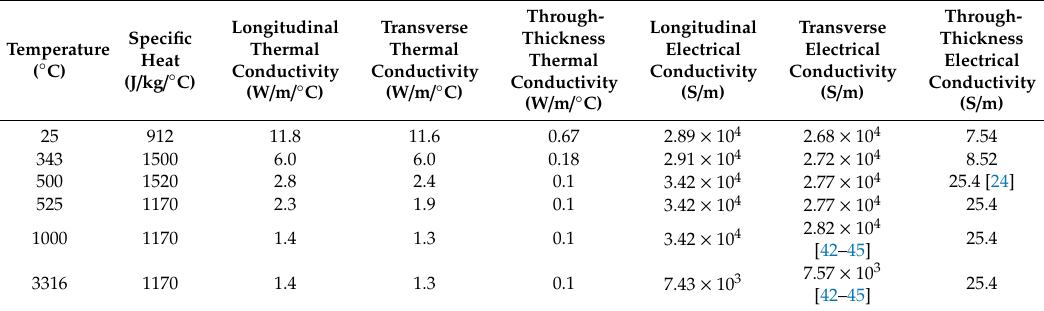
Table 4. Copper thermal and electrical material properties [24,40,46–48].